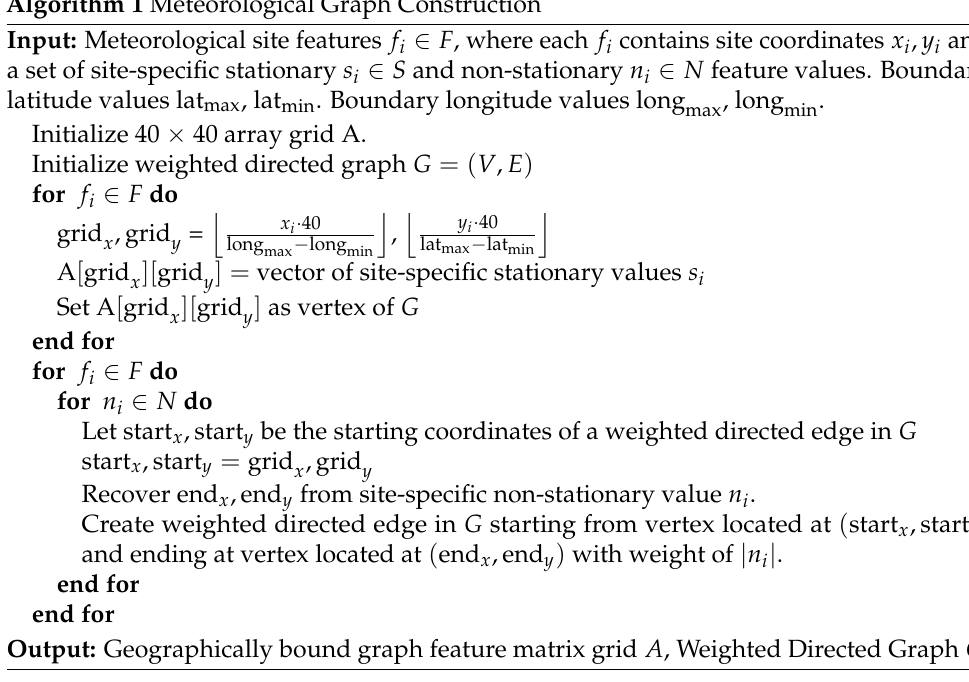
Algorithm 1 Meteorological Graph Construction